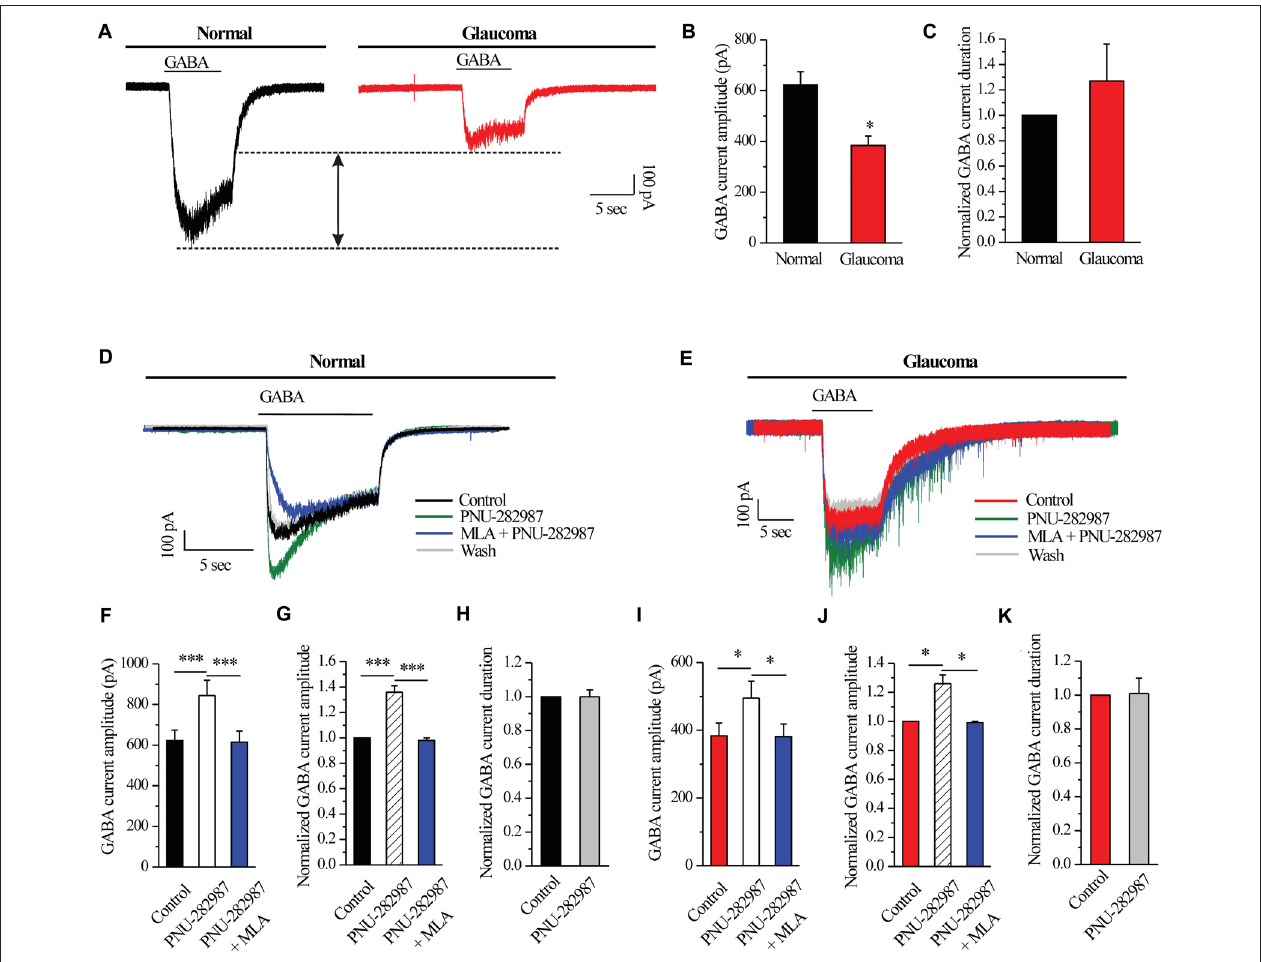
FIGURE 2 | PNU-282987 modulated GABA-elicited whole-cell currents in RGCs of the rat retina slice. (A) The membrane current responses elicited by GABA (30 µ M) from a control and glaucomatous retinal ganglion cell (RGC). (B) Bar graph illustrating the significant differences in the peak amplitudes of the responses recorded from normal ( n = 11) and glaucomatous ( n = 4) RGCs. (C) Summarized data of the duration of GABA-evoked currents ( n = 5). (D) In normal RGCs, representative GABA-induced currents in control, in the presence of 10 µ M PNU-282987, during 100 nM methyllycaconitine (MLA) + 10 µ M PNU-282987 application and after washing out the study drugs. Vertical calibration bar, 100 pA; horizontal calibration bar, 5 s. (E) In glaucomatous RGCs, representative GABA-induced currents in control, in the presence of 10 µ M PNU-282987, during 100 nM MLA + 10 µ M PNU-282987 application and after washing out study drugs. Vertical calibration bar, 100 pA; horizontal calibration bar, 5 s. (F) Statistical analysis of the GABA current amplitude from ten normal RGCs. (G) Normalized GABA current amplitude from ten normal RGCs. (H) Normalized GABA current duration from ten normal RGCs. (I) Statistical analysis of GABA current amplitude from ten glaucomatous RGCs. (J) Normalized GABA current amplitude from ten glaucomatous RGCs. (K) Normalized GABA current duration from ten glaucomatous RGCs. ∗ p < 0.05, ∗∗∗ p < 0.001 (Student’s paired t test). The results are expressed as the mean ± standard error.